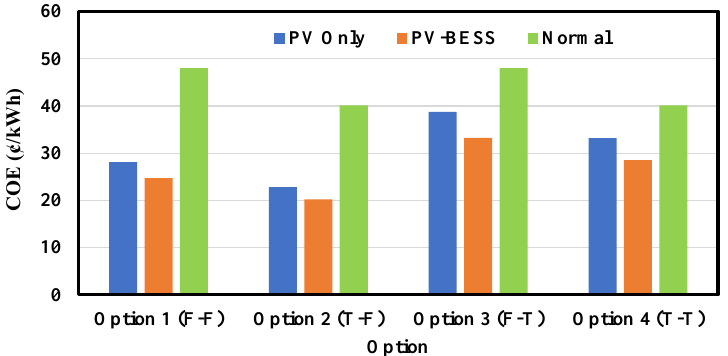
Figure 6. COE comparison of different options for the investigated system configurations.